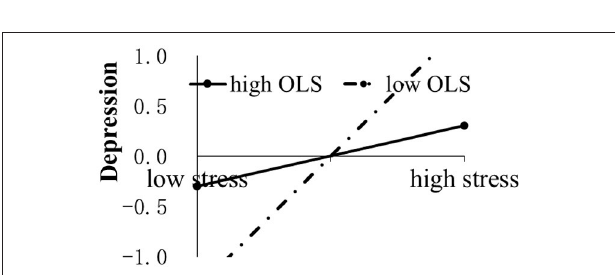
FIGURE 3 | The impact of COVID-19-related stressors (stress) on depression moderated by online learning satisfaction